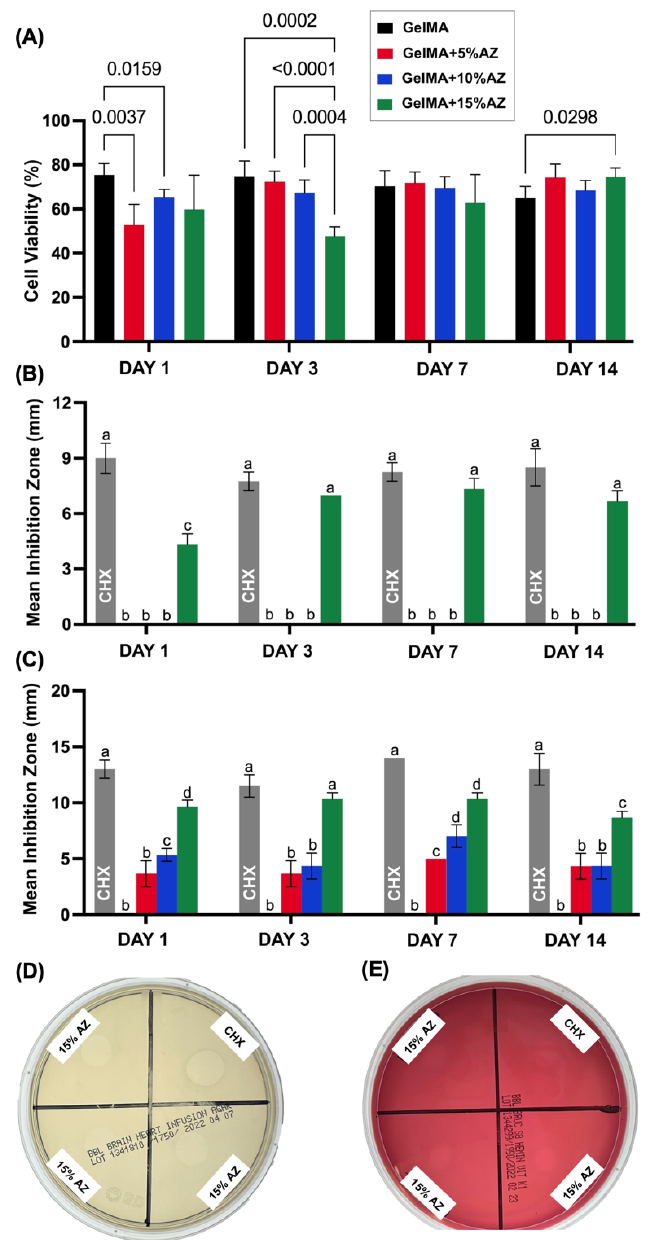
Figure 4. ( A ) Graphic representation of mean and standard deviation of hDPSCs cell viability (%) determined after 72 h using aliquots collected at 1, 3, 7, and 14 d. The percentage of cell viability was normalized by the mean absorbance of hDPSCs cultured on the plate on day 1 (100%). Absorbance was measured at 490 nm. Antimicrobial potential against Actinomyces naeslundii ( B ), and Aggregatibacter actinomycetemcomitans ( C ), evaluated through the Kirby-Bauer diffusion test ( D ) for Aa and ( E ) for An using 0.12% CHX as a positive control. Different lowercase letters represent statistical differences between groups compared on the same day ( p < 0.05).